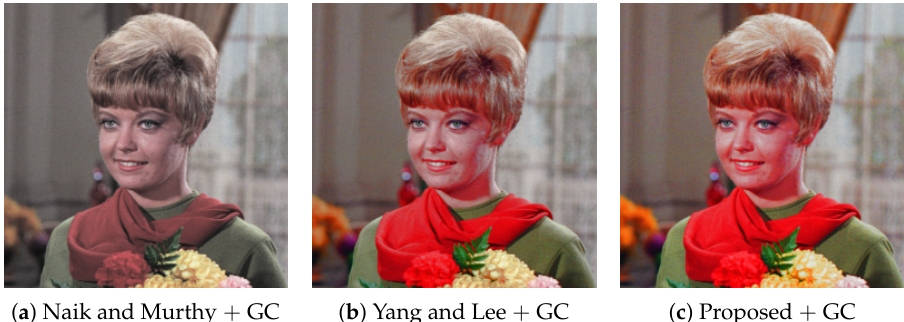
Figure 7. Gamma correction: the intensity of the input image in Figure 2a is modified by the gamma correction with γ = 0.5, which is adjusted manually. Then, the corresponding RGB color values are determined by Naik and Murthy’s method ( a ), Yang and Lee’s method ( b ) and the proposed methods ( c